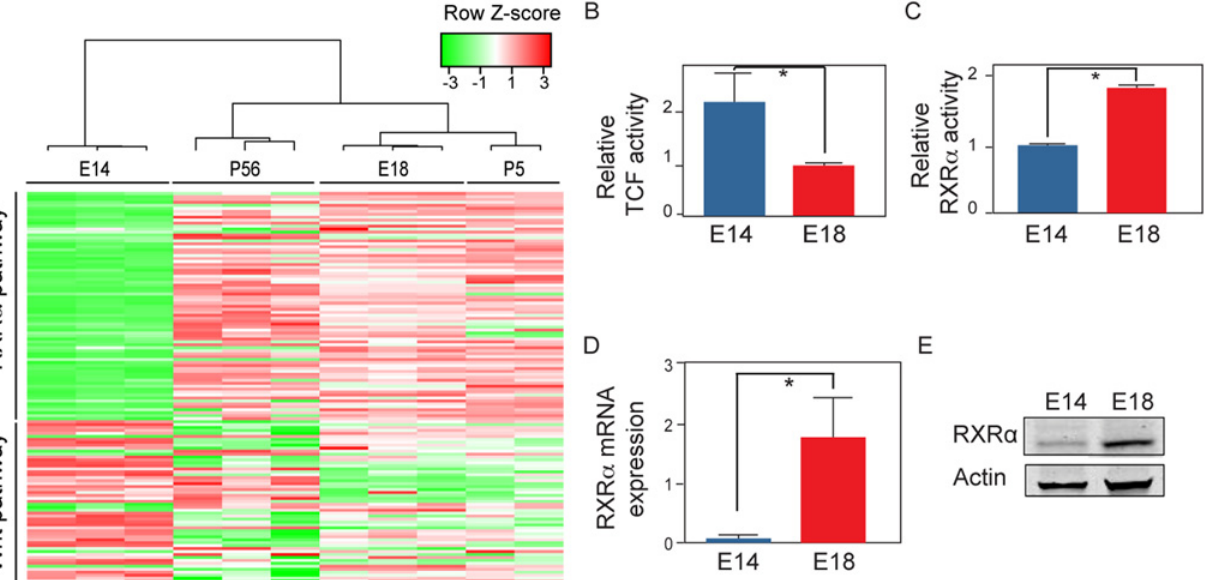
Fig 3. Gene expression and biochemical changes in RXR- α and Wnt pathways during liver development. (A) Clustering of RXR- α and Wnt pathway gene expression profiles of normal mouse liver samples taken from four different periods of development. (B) Reporter assays for Wnt and RXR pathways comparing hepatoblasts (E14) to immature hepatocytes (E18). Both TCF (p = 0.016) and (C) RXR- α activities (p = 0.021) were significantly different (D) RNA and (E) protein expression of RXR- α in hepatoblasts compared to immature